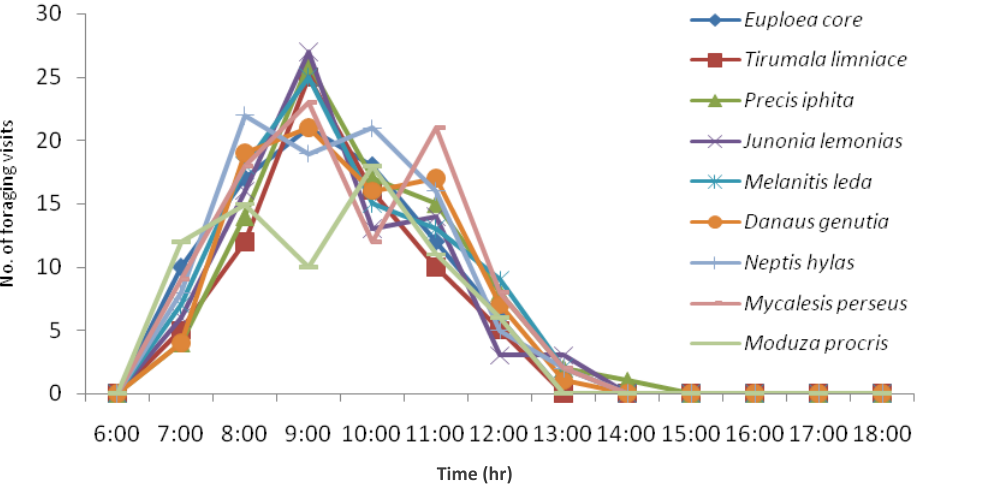
Figure 5. Hourly foraging activity of Nymphalid butterflies on Syzygium alternifolium